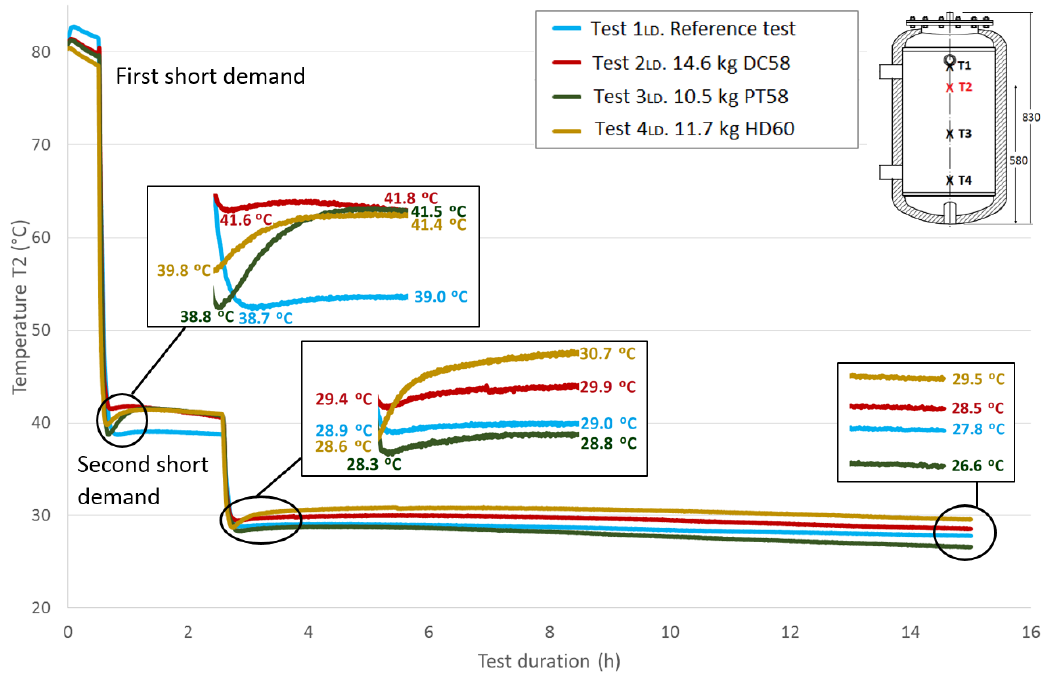
Figure 13. Medium top height water temperature ( T 2) inside the tank during the two shorts demands experiment. (dimensions are in mm).